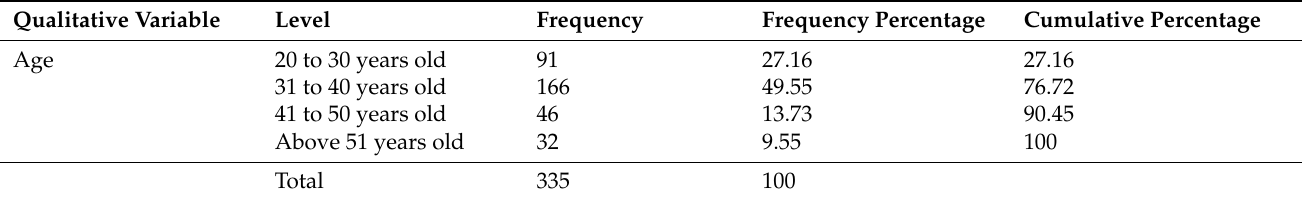
Table 30. Frequency distribution of age in the sample.